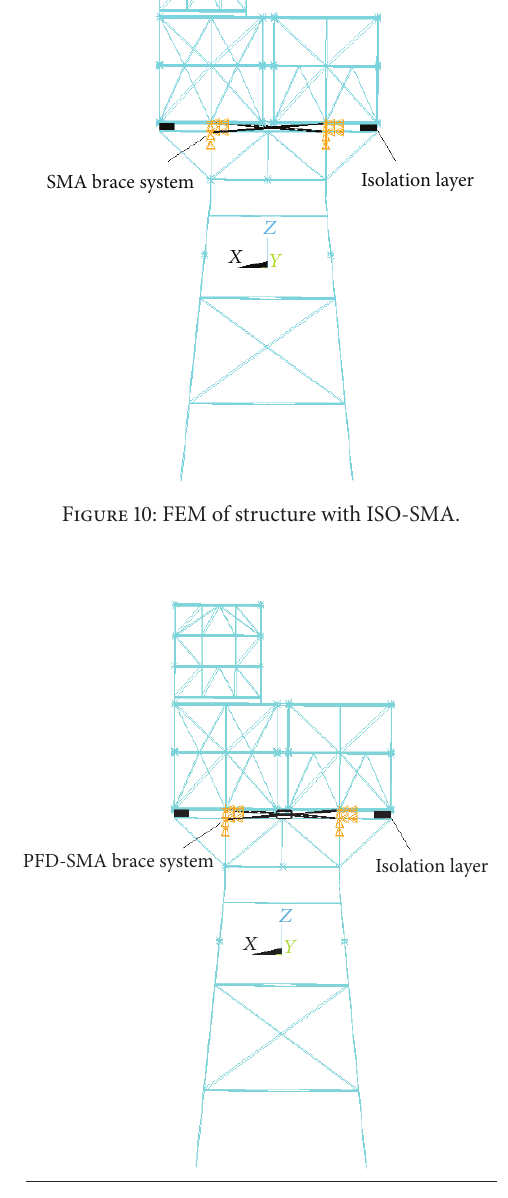
Figure 11: FEM of structure with